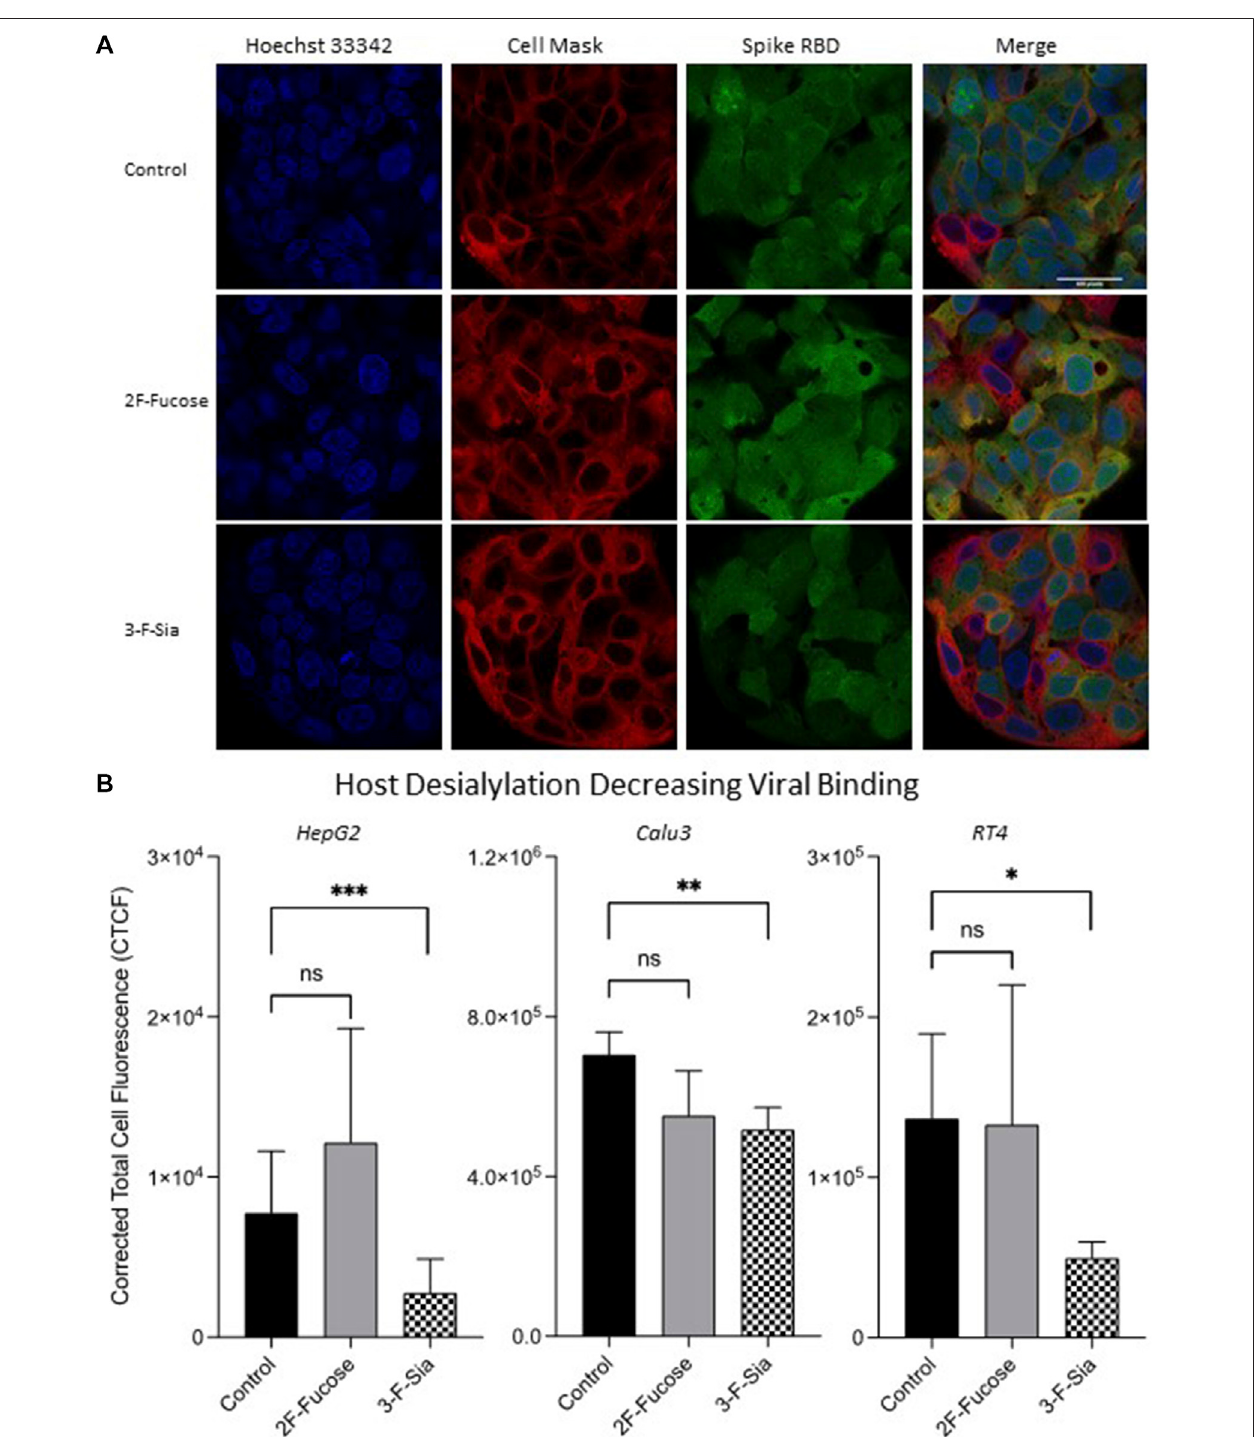
FIGURE5| RemodelinghostglycomealtersbindingbetweenhostcellsandspikeproteinRBD.2F-Fucose(FucosyltransferaseInhibitor);3-F-Sia(Sialyltransferase Inhibitor). (A) Immuno fl uorescence for S protein RBD binding with modi fi ed HepG2 cells. The columns (from left to right) show staining of nuclear acid (Hoechst 33342), plasma membrane (CellMask ™ Deep Red), S protein RBD, and merged image. Scale bar, 600 pixels. (B) Quanti fi cation of fl uorescent intensity of spike protein RBD binding. Fluorescence intensity was quanti fi ed for selected cell area. Quanti fi cation was performed with software ImageJ. Asterisks indicate the statistical signi fi cance between groups compared (* p < 0.05%; ** p < 0.01%; *** p < 0.001%; ns p < 0.05).